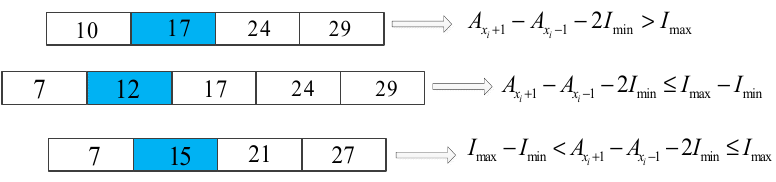
Figure 5. Illustration of the mutation operator for case 3.